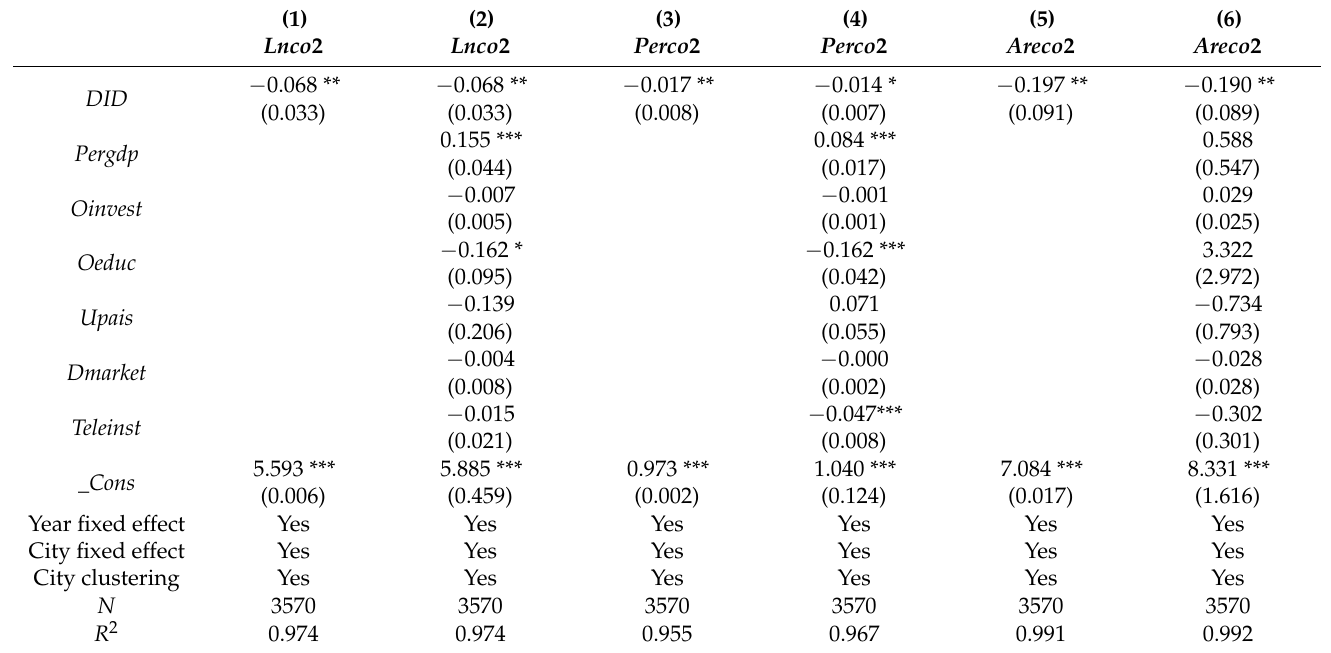
Table 2. Benchmark results